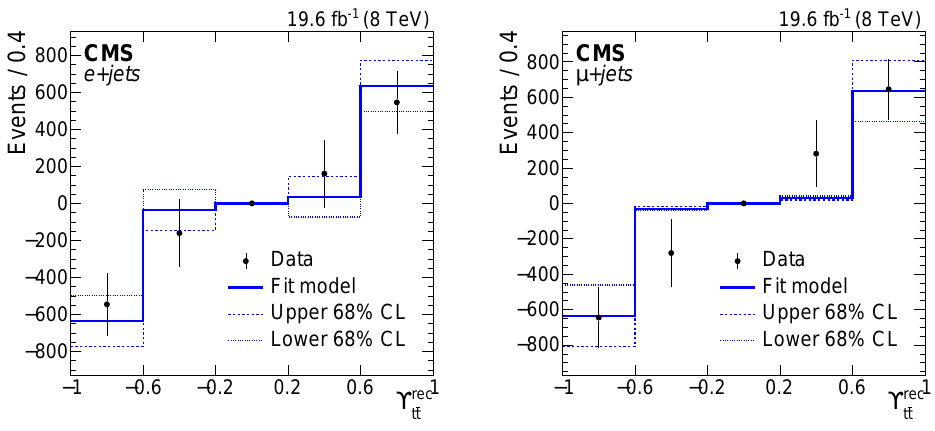
Figure 19. Antisymmetric component of the Y t ¯ t distribution in the e+jets and µ +jets channels [51]. 3.2.5. Combination of the Measurements of the t ¯ t Charge Asymmetry in the Lepton+Jets Channel by ATLAS and